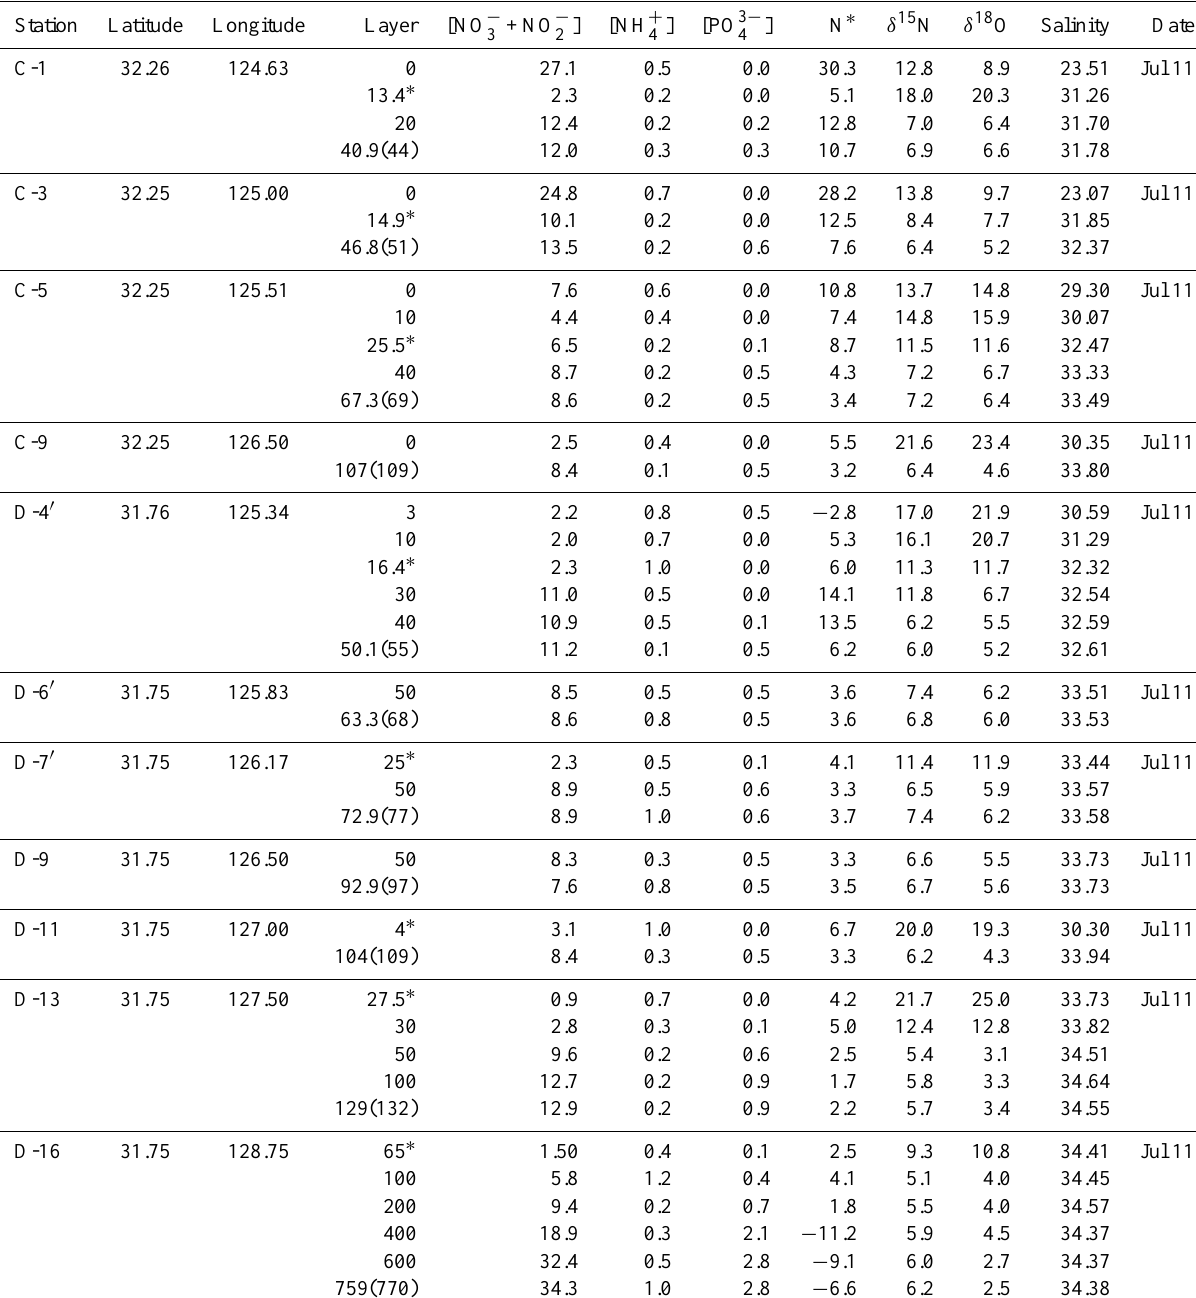
Table 3. Nitrate concentration and δ 15 N and δ 18 O in nitrate at each layer of the sampling stations in July, 2011. The depth (m) in parentheses indicates the water depth, and the layers with asterisks are the chlorophyll